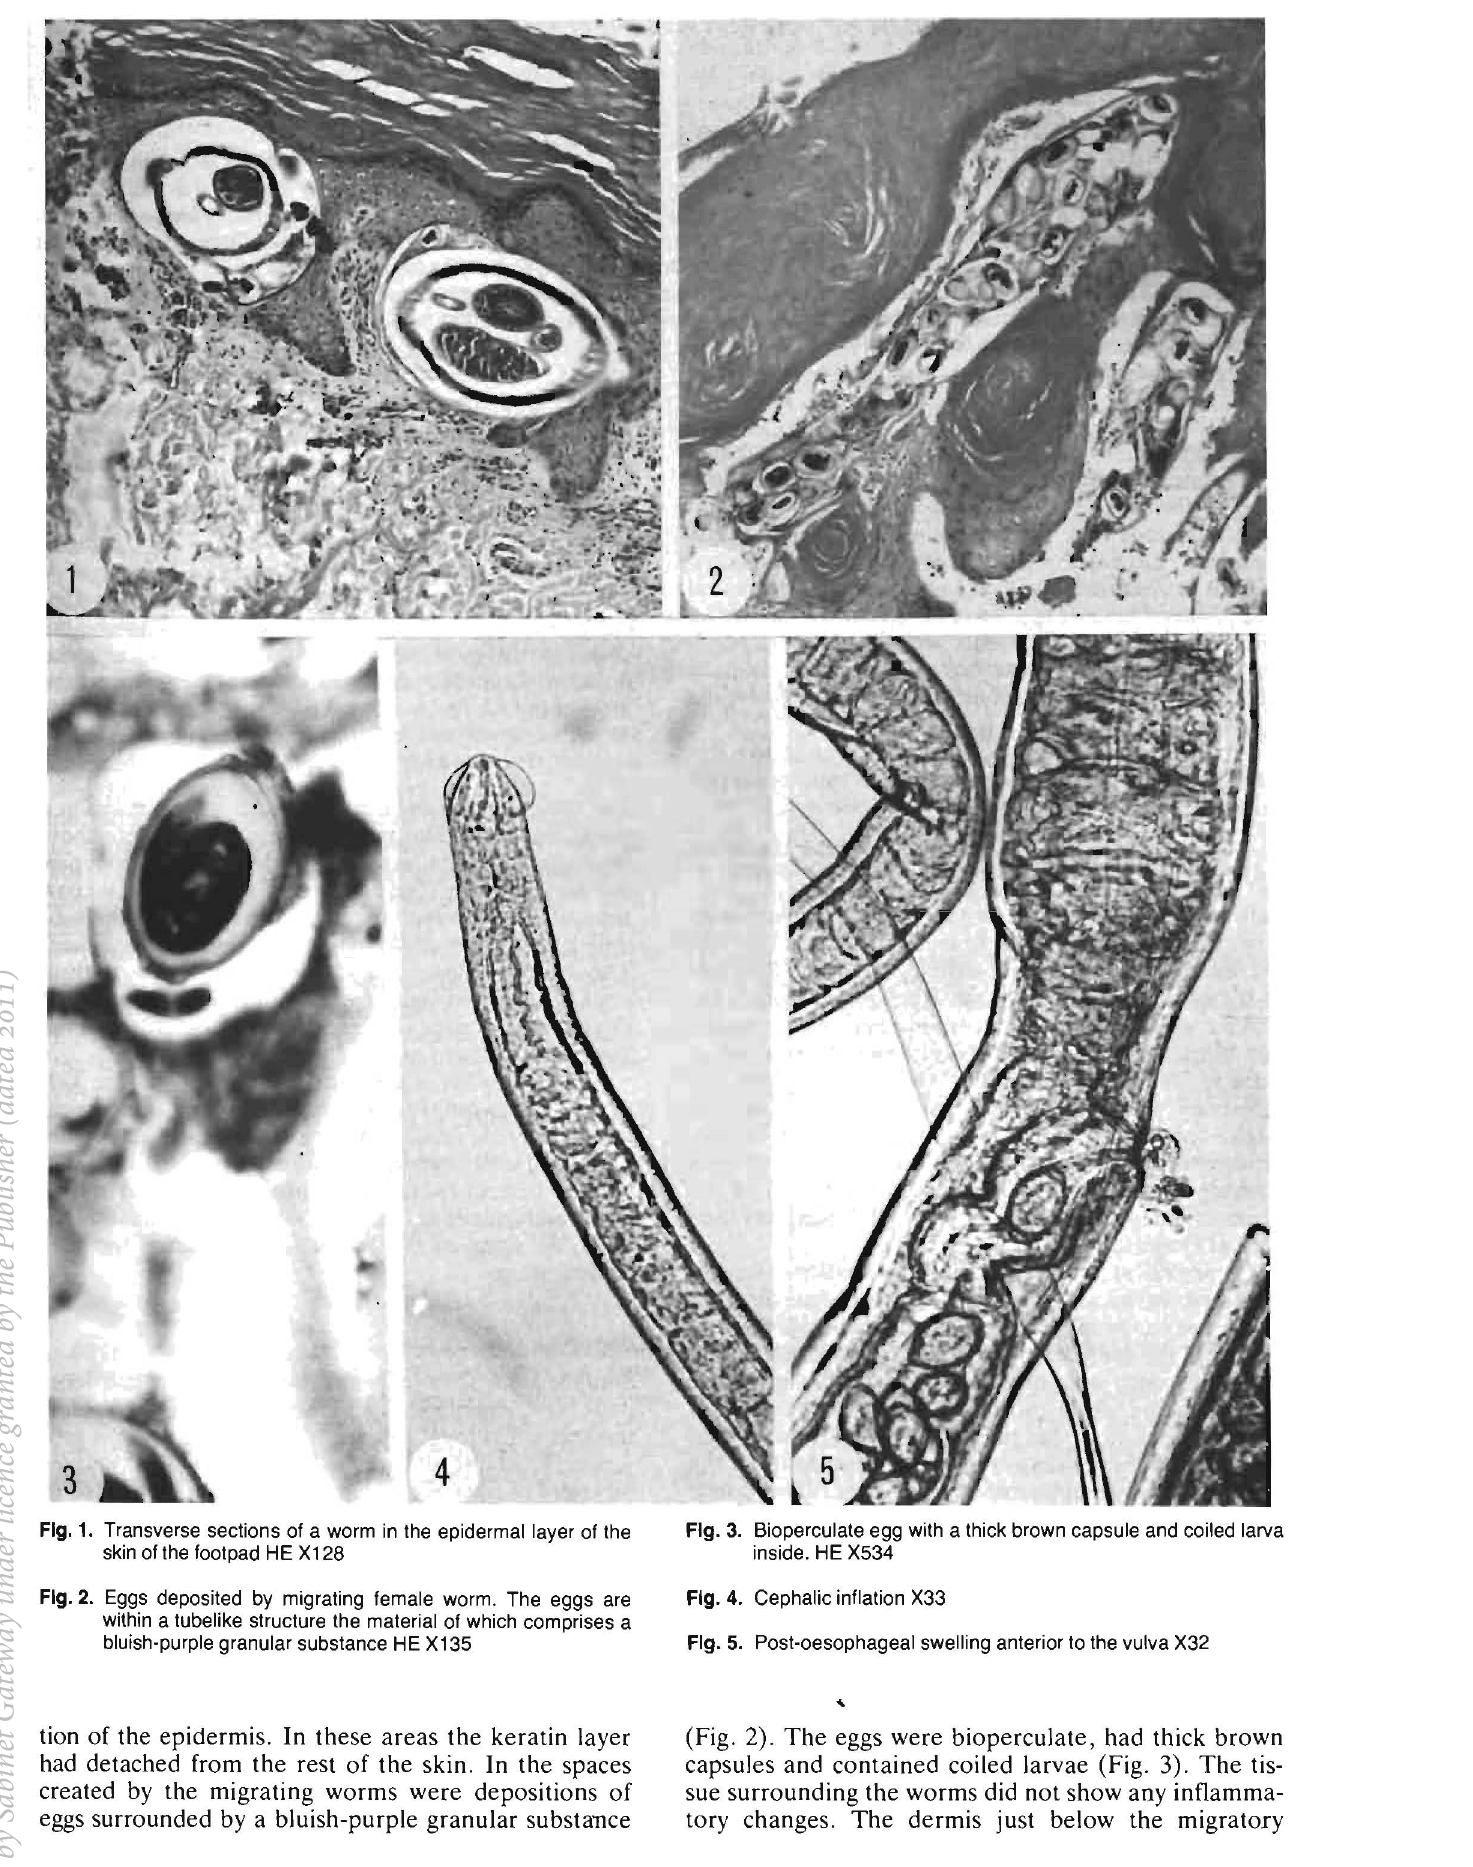
tion of the epidermis. In these areas the keratin layer had detached from the rest of the skin. In the spaces created by the migrating worms were depositions of eggs surrounded by a bluish-purple granular substance